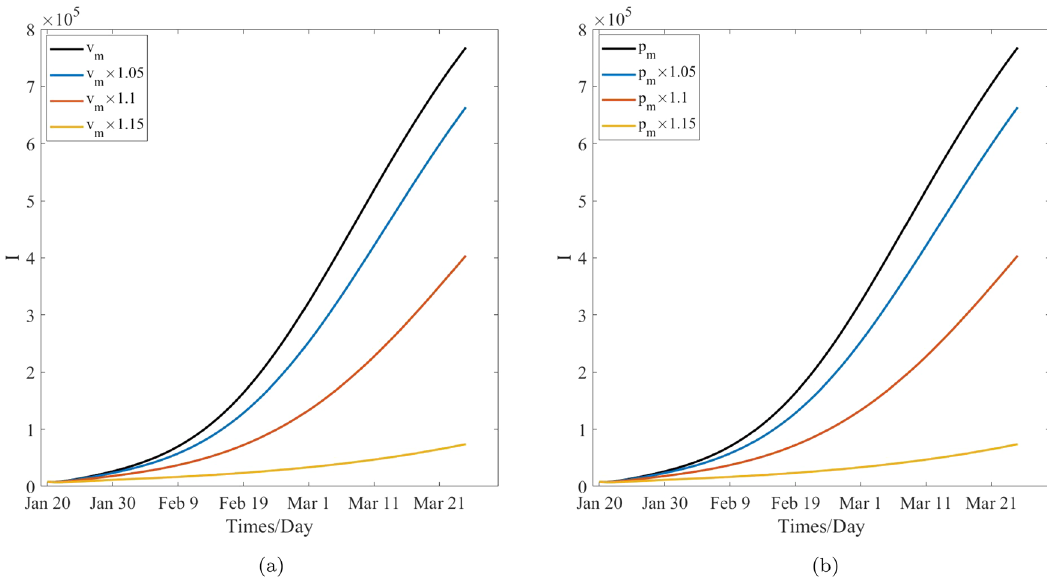
Figure 10. The effect of the critical parameters v m and p m on the newly confirmed